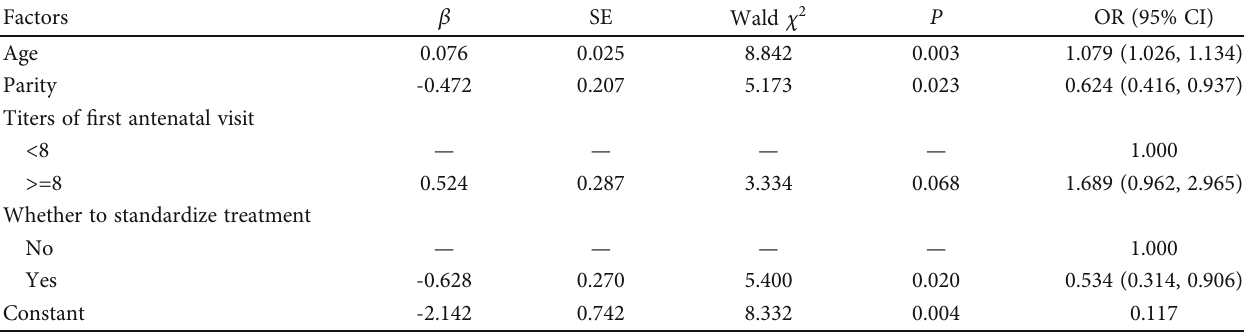
Table 3: Unconditional multivariate logistic regression model analysis of adverse pregnancy outcomes in pregnant women treated for syphilis.